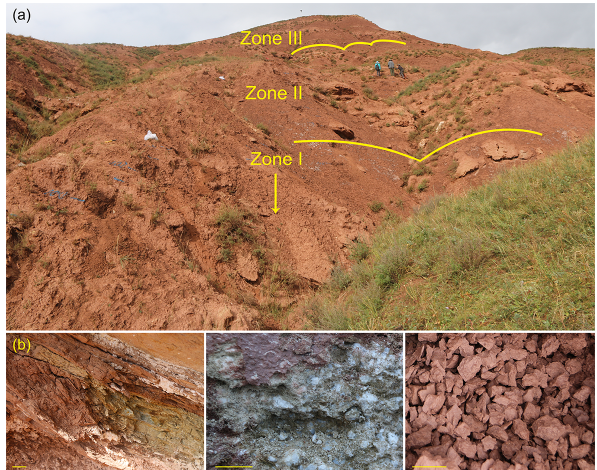
Figure 2. (a) Field photograph of the newly sampled Ria Zhong (RZ) section with palynological zones marked. The section is located in the Nangqian Basin, Yushu area, Tibet (N32 ◦ 12 (cid:48) 10", E96 ◦ 27 (cid:48) 19.42"; altitude 3681m), and it represents the uppermost Gouriwa member of the Eg 3 unit in the Cenozoic Gongjue For- mation. The lithostratigraphy and geochemistry of the RZ section are further described in Yuan et al. (2020). (b) Field photographs showing representative lithologies in the RZ section (from left to right): intercalated siltstone and mudstone, massive gypsum, silty mudstone. The scale bar represents